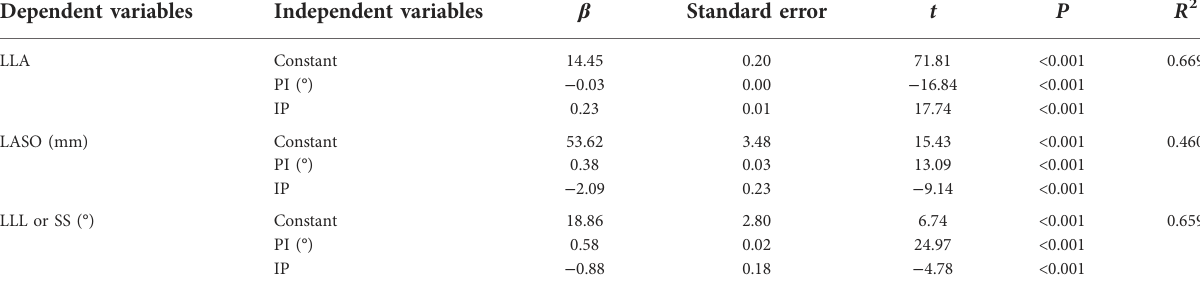
TABLE 5 Stepwise multiple linear regressions.